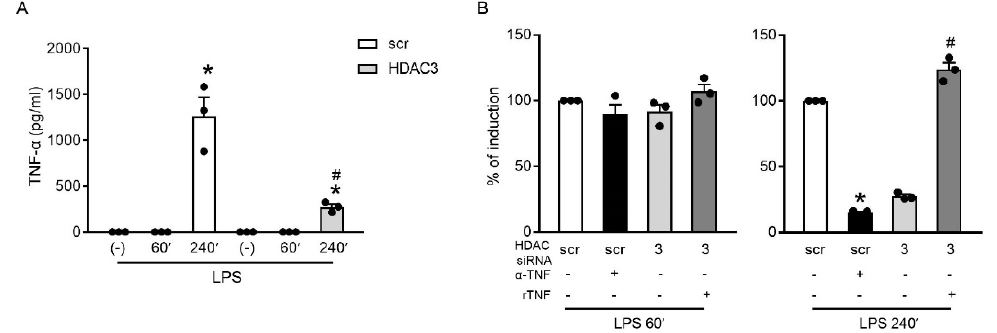
Figure 5. HDAC3 indirectly regulated the expression of TNFAIP3 by inducing TNF- α . ( A ) RAW246.7 cells transfected with scr or HDAC3 siRNAs were treated or not with 1 µ g/mL LPS for 60 and 240 min. Secreted TNF- α was detected in cell-free supernatants using ELISA. The results depict the mean ± SEM ( n = 3). * p < 0.05 versus respective (-) using an unpaired t -test. ( B ) RAW246.7 cells transfected with scr or HDAC3 siRNAs were treated or not with 1 µg/mL LPS for 60 and 240 min with or without an anti-TNF- α -blocking antibody or recombinant murine TNF- α prior to mRNA extraction. The expression of TNFAIP3 was investigated at the mRNA level using RT-PCR. Data were normalized to the housekeeping RNA (18S) and expressed as the mean ± SEM ( n = 3) of the percentage of production in LPS-stimulated scr cells. * p < 0.05 versus untreated scr or # p < 0.05 versus untreated HDAC3 siRNA using an unpaired t -test. Dots represent results of individual experiments.